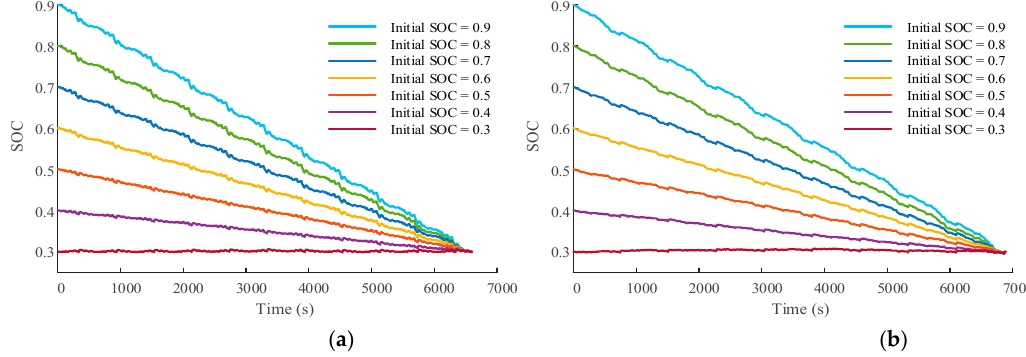
Figure 5. Dynamic programming (DP)-approximate equivalent fuel consumption minimum control strategy (A-ECMS) algorithm battery state of charge (SOC) change curve, ( a ) 11-SC03; ( b ) 9-HWFET.